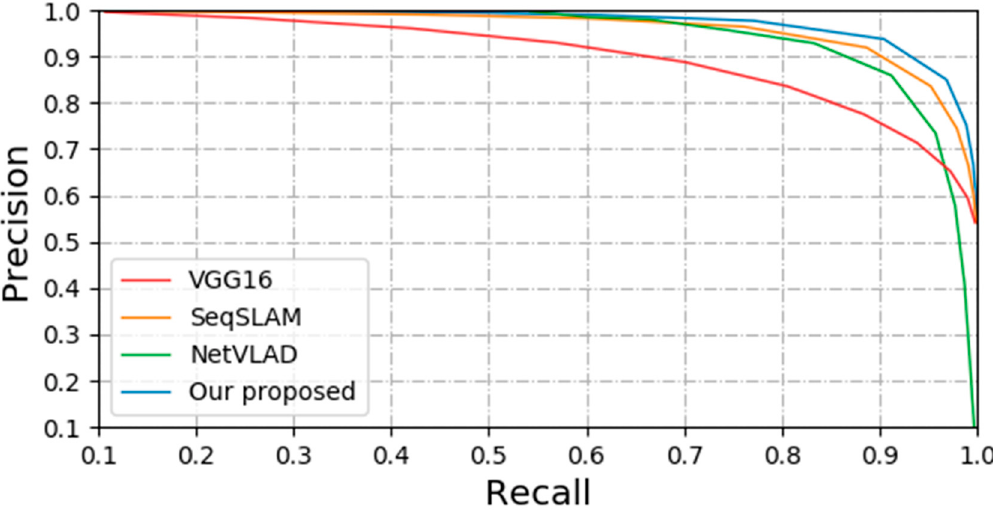
Figure 7. The performance comparison between our proposed method and other three methods in the Nordland dataset.